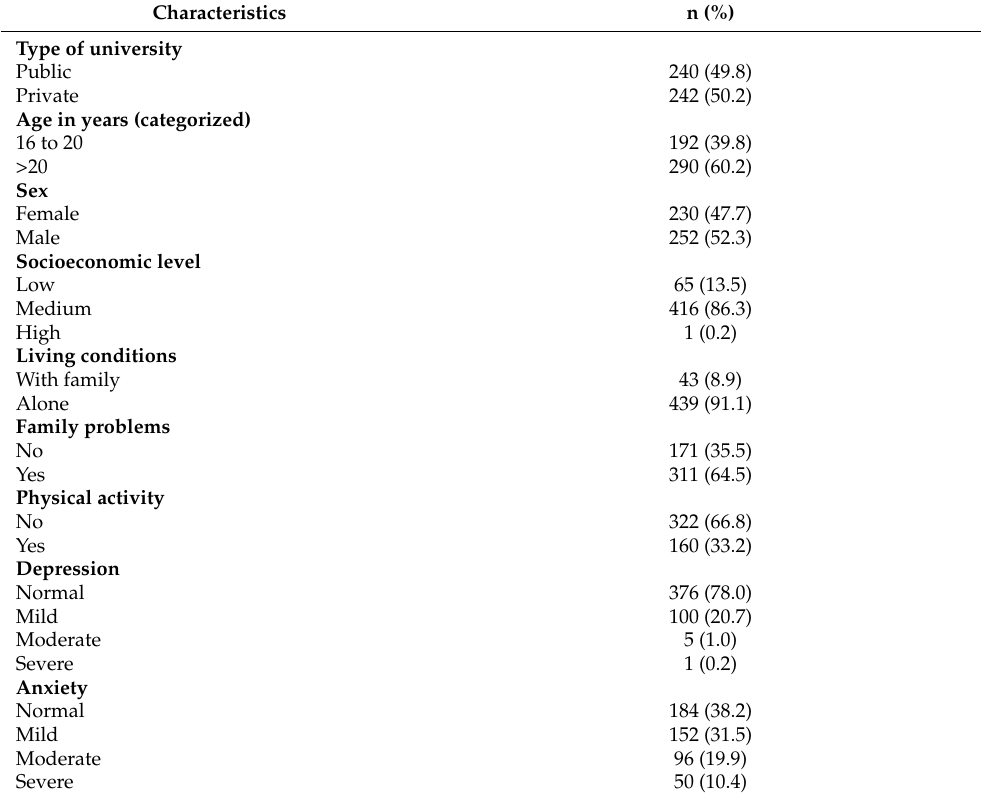
Table 1. Socio-educational characteristics of medical students from Lambayeque, Peru.